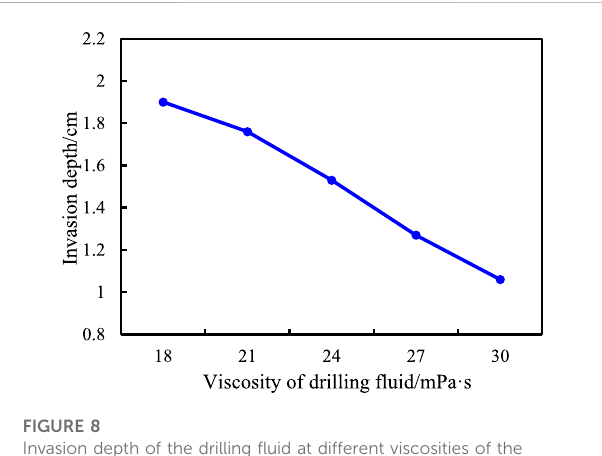
FIGURE 7 Invasion depth of the drilling fl uid at different angles to the bedding plane.